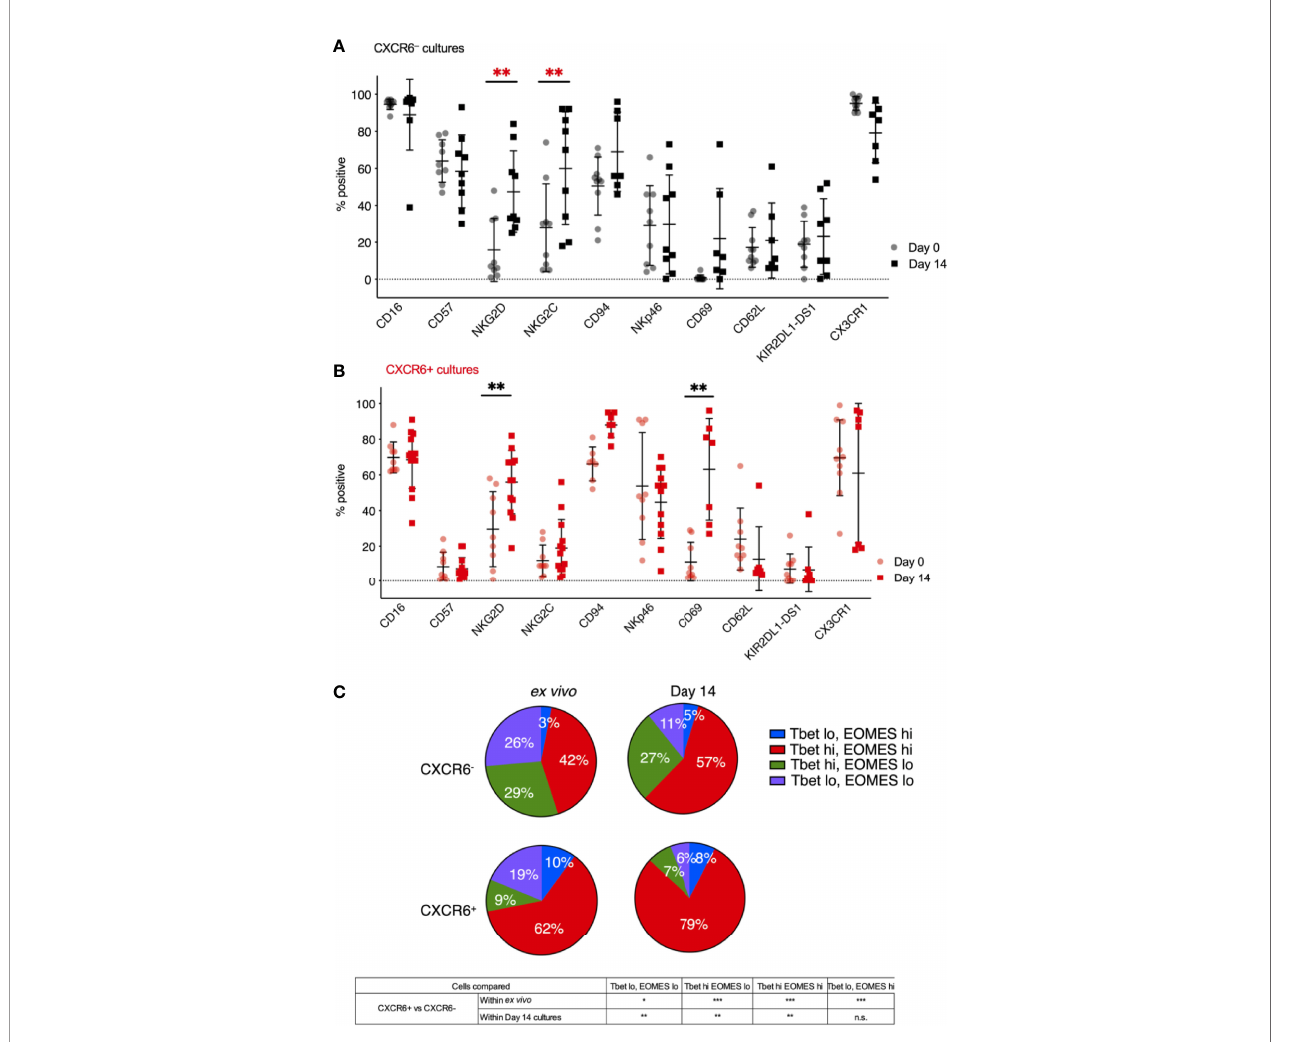
FIGURE 2 | CXCR6 - NK (A) and CXCR6 + NK (B) remain phenotypically stable over 14 days in culture, except for increases in NKG2D, NKG2C, and CD69 ( n=7-9 ). Not all cultures are paired for all markers, so a two-way ANOVA with Holm-Sidak multiple comparison ’ s tests was performed. P values are as denoted in the legend to Figure 1 . (C) Four subsets of CXCR6 + and CXCR6 – PB-NK cells were identi fi ed in ex vivo and in vitro expanded NK cells based on their T-bet and Eomes expression: T-bet lo Eomes lo (purple), T-bet lo Eomes hi (blue), T-bet hi Eomes lo (green), and T-bet hi Eomes hi (red). Intranuclear transcription factor staining, and fl ow cytometry analyses was performed. Paired t-test was used for comparisons. Statistical signi fi cance is shown below. FMOs are shown in Supplementary Figure 3C . *p < 0.05; **p < 0.01; ***p < 0.001; ns, not signi fi